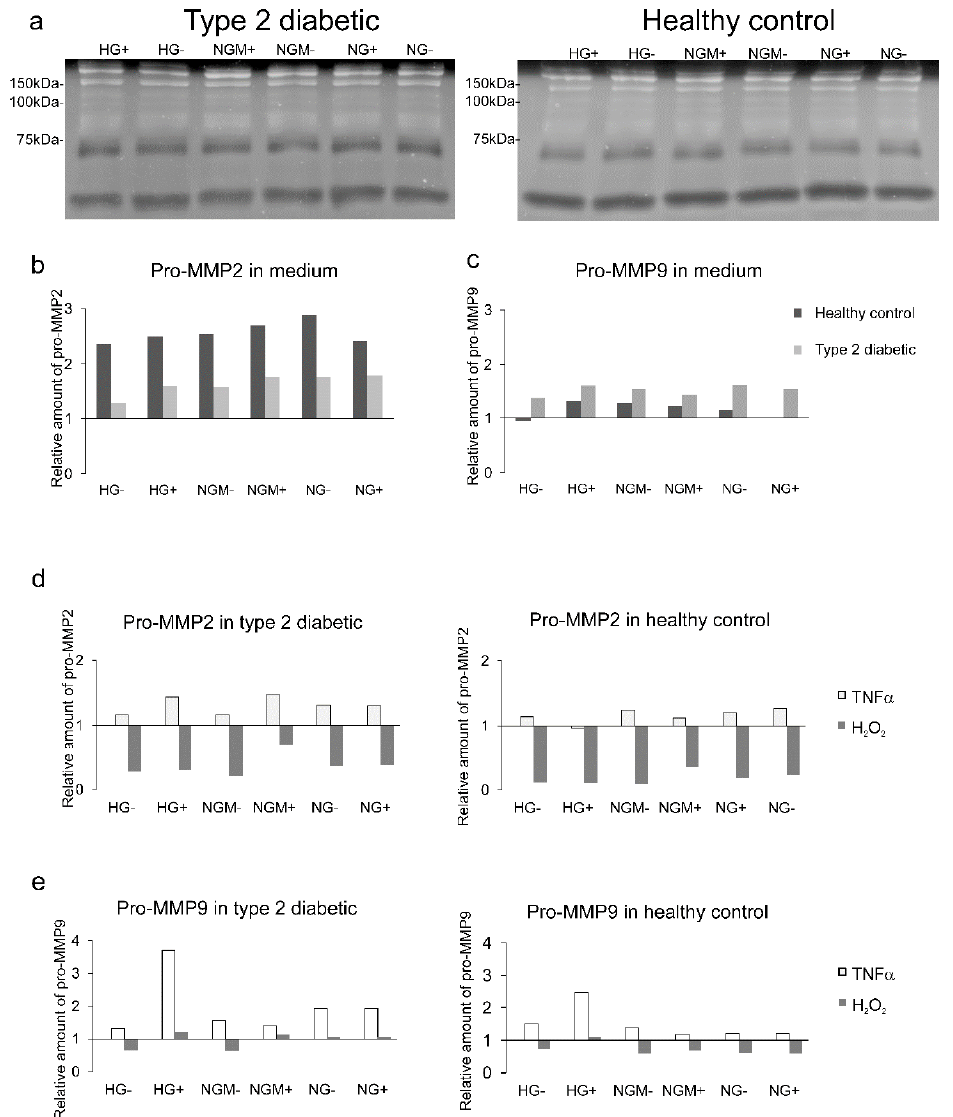
Figure 9. Effects of different glucose concentrations, and cytokine and oxidative stress on pro-MMP secretion. The type 2 diabetic (UTA.08203.DMs) and healthy control (UTA.10212.EURCCs and UTA.10902.EURCCs) hiPSC-RPEs were cultured in different glucose and insulin concentrations (see treatments and abbreviations below) in the presence or absence (+/ − ) of added insulin ( a – d ), and in the presence or absence of TNF α (48 h) or H 2 O 2 (1 h + 23 h). ( a ) represents the exemplary zymographies with diabetic (left) and healthy (right) control samples. The densitometric evaluation of zymograms are shown in panels ( b – d ). The densitometric analysis of pro-MMP2 ( b ) and pro-MMP9 were normalized to a 100 kDa marker ( c ). The densitometric evaluation of pro-MMP2 after 10 ng/mL TNF α (48h) or 300 mM H 2 O 2 (1 h + 23 h) in diabetic or healthy control hiPSC-RPE, and the values are correlated to the untreated sample, which is marked as 1 ( d ). The densitometric evaluation of pro-High molecular weight matrix metalloproteinase (HMW MMP) after 10 ng/mL TNF α or 300 mM H 2 O 2 (1 h + 23 h) in diabetic or healthy control hiPSC-RPEs, where the values are correlated to the untreated sample, which is marked as 1 ( e ). Treatments and their abbreviations: high glucose (HG, 25 mM), normal glucose 5 mM balanced with mannitol 19.5 mM (NGM), or normal glucose (NG, 5 mM) in the presence or absence ( +/ − ) of added